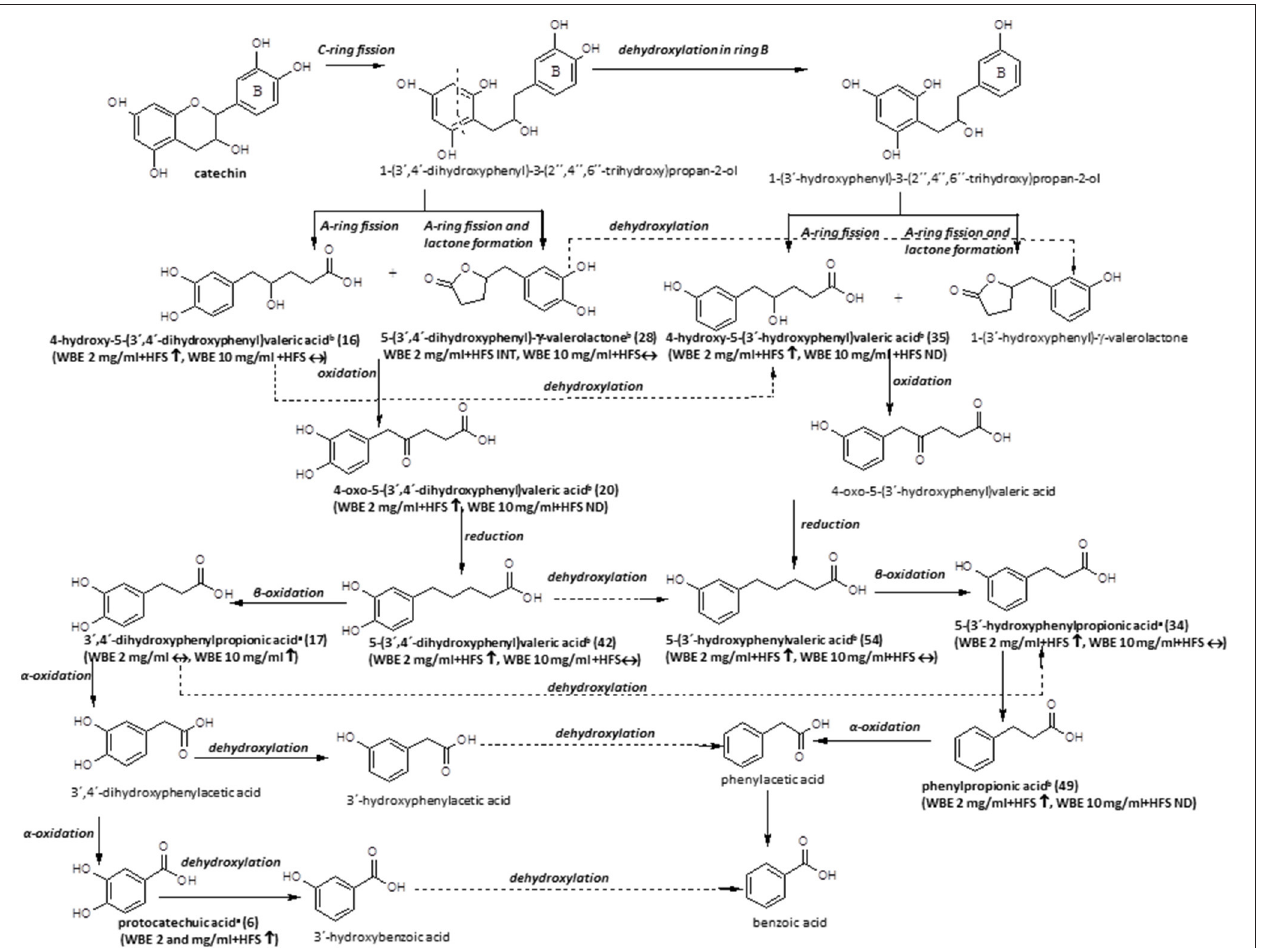
FIGURE 6 | Microbial metabolism of catechin as described in the literature (Appeldoorn et al., 2009; Monagas et al., 2010; Takagaki and Nanjo, 2013). Metabolites detected in the present study are printed in bold (a: identified by comparison with authentic reference compound; b: tentatively identified on basis of HRMS, molecular formula and fragmentation pattern; WBE, willow bark extract; HFS, human fecal suspension; INT, intermediate; ↑ , significantly increasing over time (ratio t24/t0 > 2, p < 0.05); ↓ : significantly decreasing over time (ratio t24/t0 < 0.5; p < 0.05); ↔ : no significant change over